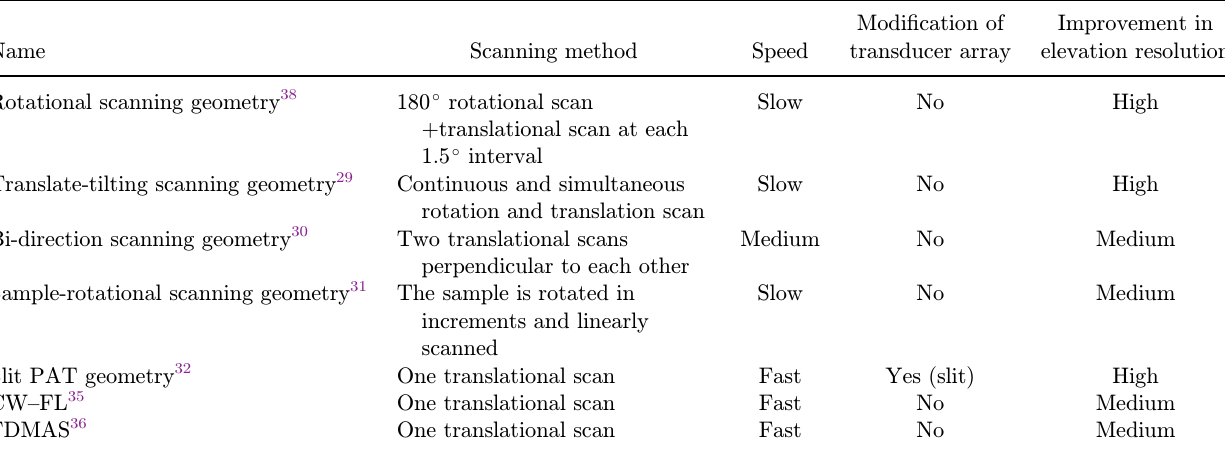
Table 1. Comparison of di®erent methods for improving the elevation resolution in a linear array. 35 The table was reproduced with permission from Ref.